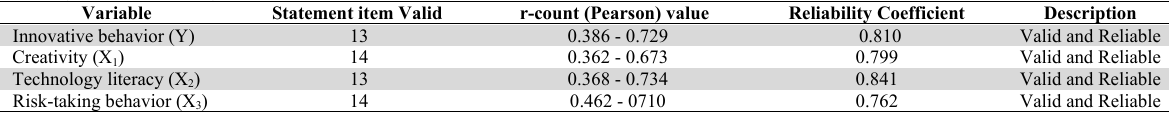
Validity and Reliability Test Results of Y, X 1, X 2 and X 3 Variables Variable